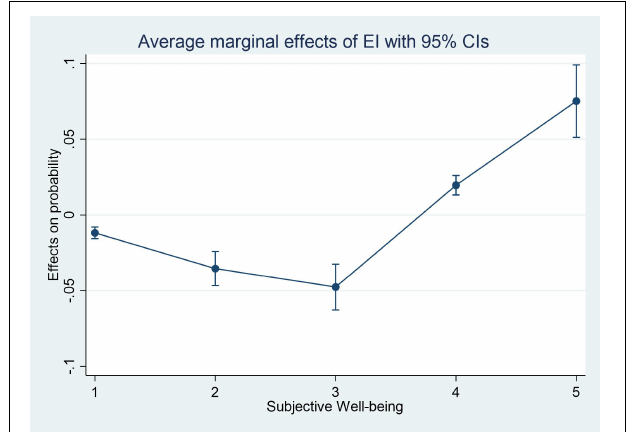
FIGURE 2 | The marginal effect of inequality of effort on different subjective